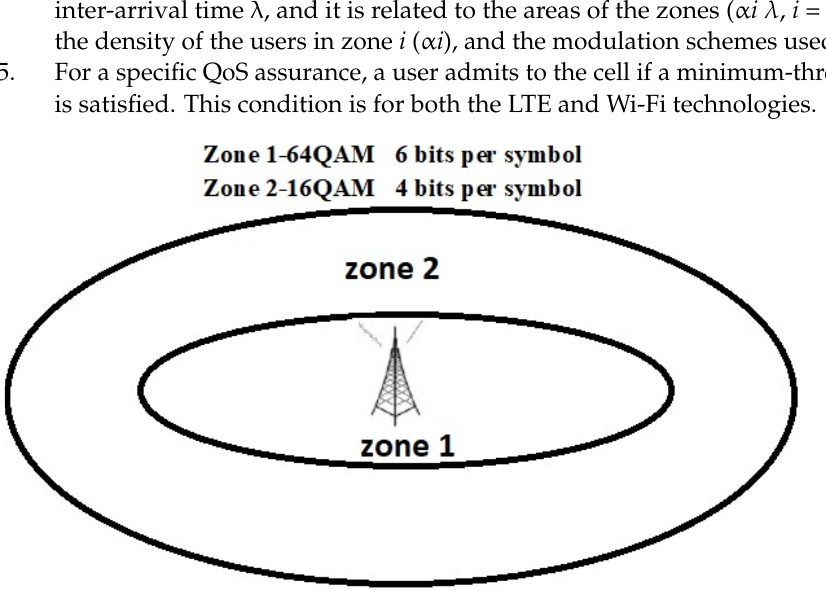
Figure 2. LTE cell divided into two zones.